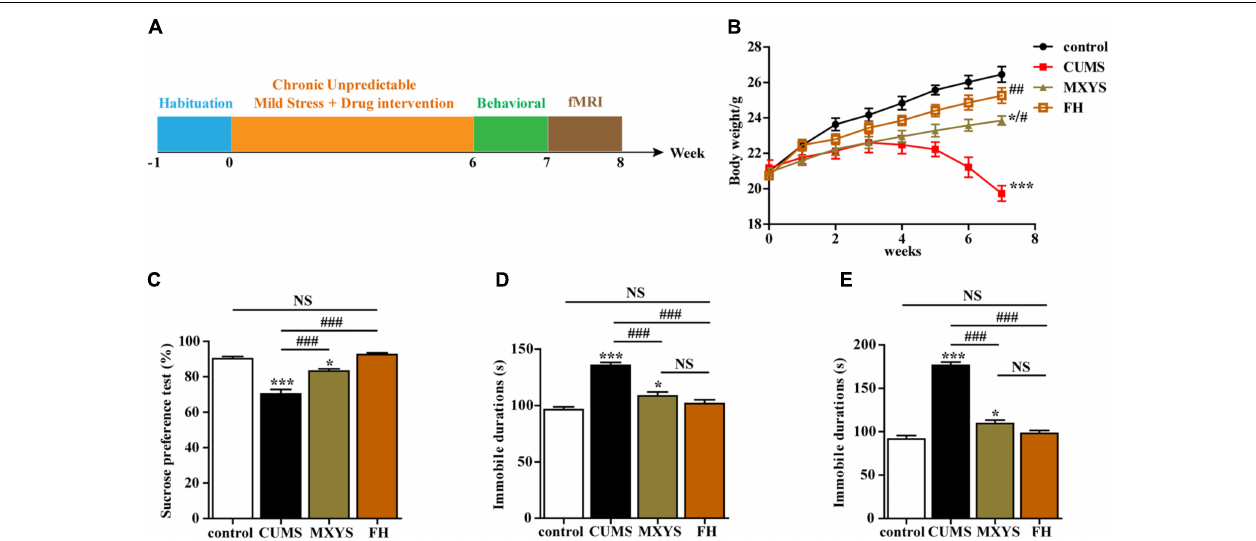
FIGURE 1 | Effects of MXYS on depressive-like behaviors. (A) Schematic representation of the experimental design used for this study. All animals received the same amount of handling, behavioral testing, and fMRI detection. (B) Body weight gain. The body weights of mice were recorded weekly. (C) Effects of the CUMS treatment on sucrose preference. (D) Immobility time in the TST. (E) Immobility time in the FST. The data are presented as means ± SEM. ∗ P < 0.05, ∗∗∗ P < 0.001 versus control group; # P < 0.05, ## P < 0.01, ### P < 0.001 versus CUMS group; NS, P >